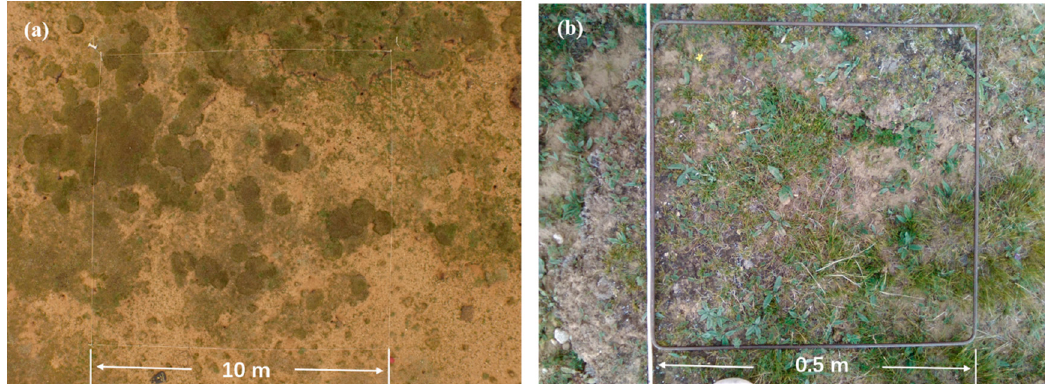
Figure 2. Field sampling methods and effect diagrams ( a ) unmanned aerial vehicle (UAV) sampling method; ( b ) ground sampling method.